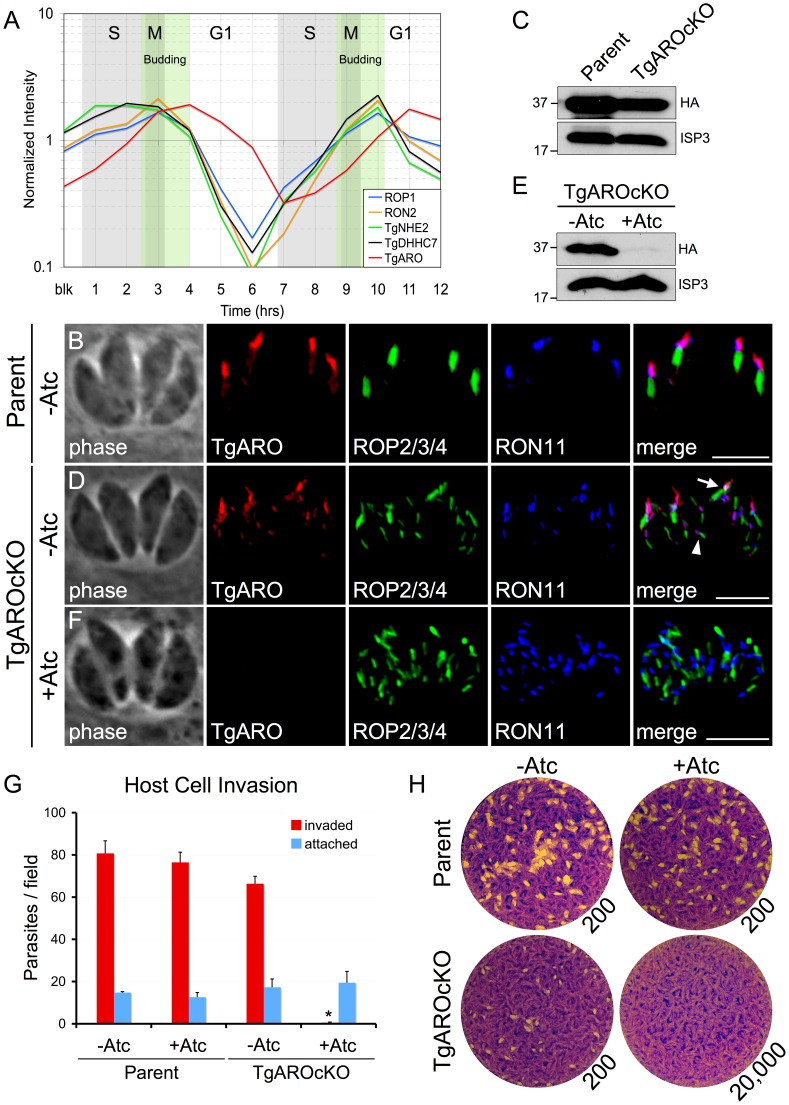
TgARO is required for apical rhoptry tethering and host cell invasion.(A) Expression of TgARO is delayed about one hour after other rhoptry proteins. Expression of representative genes from several classes of rhoptry proteins are shown including ROP1 (rhoptry body proteins), RON2 (rhoptry neck proteins) and the Na+/H+ exchanger TgNHE2 and TgDHHC7 (multipass integral membrane rhoptry proteins). (B) IFA showing endogenously tagged TgARO-3xHA is distributed along the surface of the entire rhoptry and concentrated at the apex of the organelle. Red: rabbit anti-HA antibody detected by Alexa594-anti-rabbit IgG. Green: mouse anti-ROP2/3/4 antibody detected by Alexa488-anti-mouse IgG. Blue: rat anti-RON11 antibody detected by Alexa350-anti-rat IgG. All scale bars = 5 µm. (C) Western blot showing lower levels of TgARO following promoter replacement. ISP3 serves as a loading control. (D) Untreated TgAROcKO parasites maintain an apical rhoptry bundle (arrow) but also display some dispersed rhoptries (arrowhead). TgARO is visible not only in the apical bundle but also at the apex of each of the individual dispersed rhoptries. (E) Western blot showing knockdown of TgARO after 48 hours of growth with Atc. ISP3 serves as a loading control. (F) Following Atc treatment, cells are depleted of TgARO and the apical bundle of rhoptries is completely lost with the rhoptries scattered throughout the cytosol. (G) Parasites depleted of TgARO encounter a complete block in invasion. Parental or TgAROcKO parasites were grown for 48 hours−/+Atc and then allowed to invade into fresh host cells for one hour. Following depletion of TgARO, parasites show a nearly complete block in host penetration (asterisk, p-value<0.001). A corresponding increase in attached, uninvaded parasites is not seen (blue bars). A minor decrease in penetration is also seen for untreated TgAROcKO, likely due to the lower levels of TgARO expressed in this strain relative to the parental line. (H) Parasites depleted of TgARO cannot form plaques in fibroblast monolayers. Parental or TgAROcKO parasites were grown 48 hours−/+Atc and then infected into fresh fibroblast monolayers at an infective dose of 200 parasites per well and allowed to incubate for nine days. TgAROcKO parasites are unable to form plaques in the presence of Atc, even at an infective dose of 20,000 parasites per well.